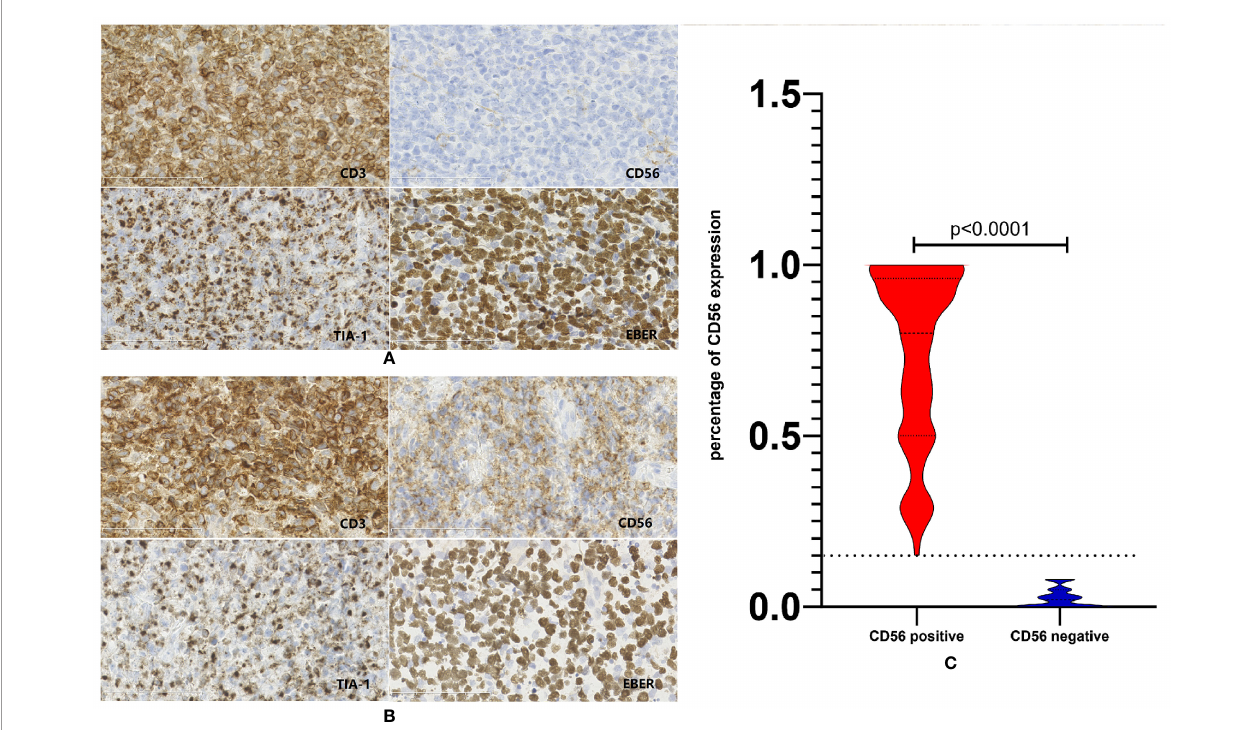
FIGURE 1 | Expression status of CD56 in patients with NKTCL. (A) Representative case of NKTCL de fi ned as CD56 negative. (B) Representative case of NKTCL de fi ned as CD56 positive. (C) Violin plot of CD56 expression status in the whole cohort of